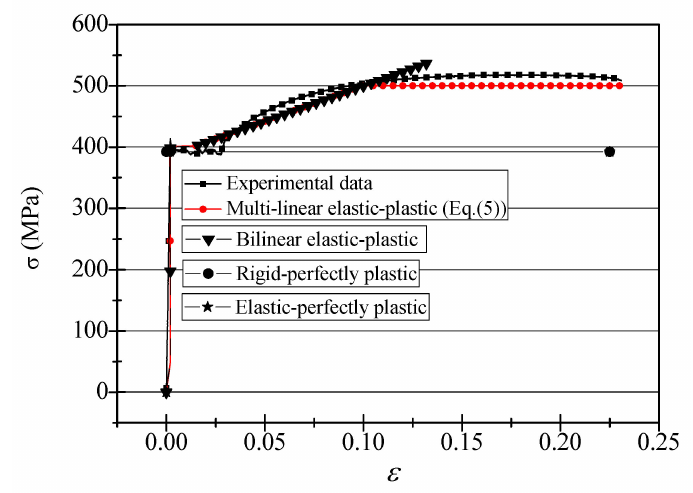
Figure 9. Fitted constitutive models of EH36 steel at room temperature.